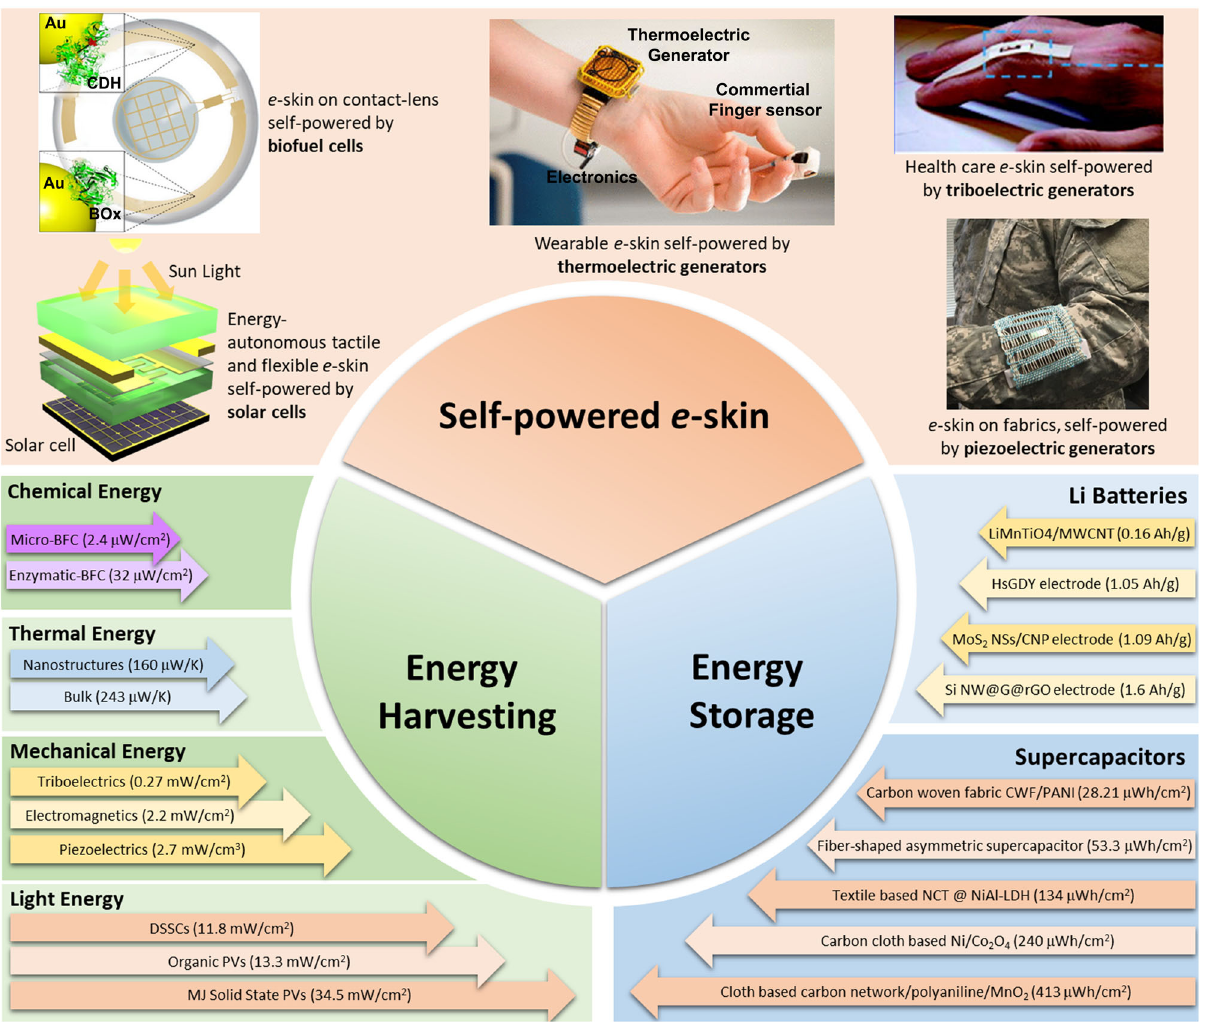
Fig. 2 Energy-autonomous electronic skin: potential energy sources. The schematic diagram of self-powered e -skin, comprising: (i) energy harvesting (light, mechanical, chemical and thermal energy), (ii) energy storage (batteries and supercapacitors) and (iii) examples of self-powered e -skin solutions. Energy harvesting: the illustration compiles the best performance energy harvesters and their corresponding energy outcome (i.e. power density) depending on the energy source (light, 66,73,81 mechanical, 98,103 chemical 32,33 and thermal energy 133,137 ), highlighting successful devices exhibiting features including stretchability, lightweight, output powers and wearability. Energy storage: highlighting various fl exible active electrodes that enhance the performance of LiBs 169,220 – 222 and textile/ fi bre/cloth-based supercapacitors 223 – 227 for wearable systems. Examples of self-powered e -skin solutions: the illustration shows representative examples of electronic devices continuously self-powered by various energy sources, including tactile e -skin for robots self-powered by sunlight (reprinted with permission from García Núñez et al. 1 Copyright © 2017, John Wiley and Sons), e -skin self-powered by a biofuel cell and integrated on a contact-lens (reprinted with permission from Falk et al. 34 Copyright © 2012 Elsevier B.V), wearable sensors self-powered by thermoelectric generators (reprinted with permission from Leonov et al. 54 Copyright © 2009, AIP Publishing), wearable e -patch for human health monitoring (reprinted with permission from Yang et al. 55 Copyright © 2009, American Chemical Society), multi-sensing e -skin on fabrics self-powered by piezoelectric generators (Reprinted with permission from Li et al. 56 Copyright